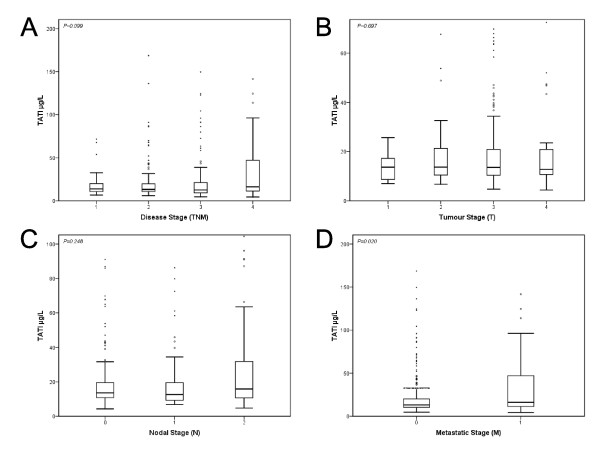
Distribution of s-TATI according to disease stage. Box plots displaying s-TATI distribution in TNM Stage and subcategories. Boxes show 25th, 50th, 75th percentiles, whiskers show 5th and 95th percentile. Outliers are represented with circles while black dots represent extreme outliers. Distribution of s-TATI according to TNM stage (A), tumour stage (B), nodal stage (C) and metastatic stage (D). Kruskal Wallis test was used for statistical analysis.